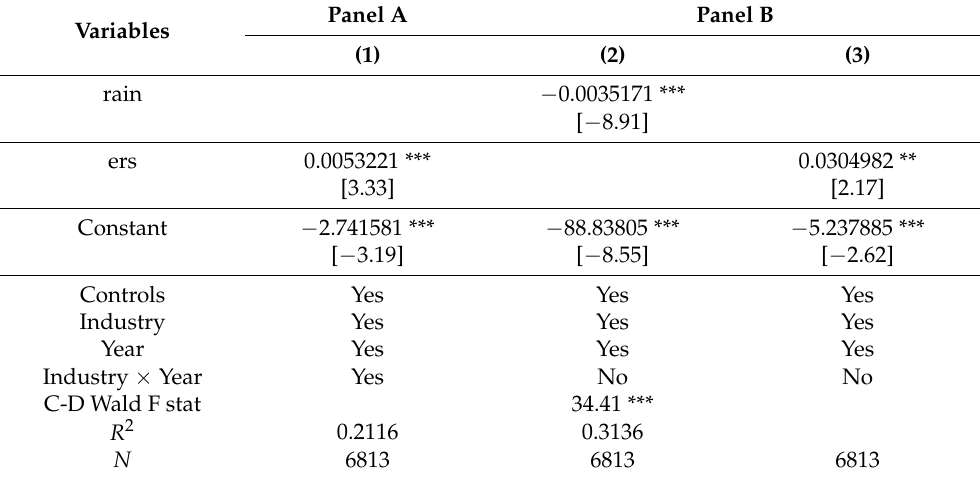
Table 6. Endogeneity test results.